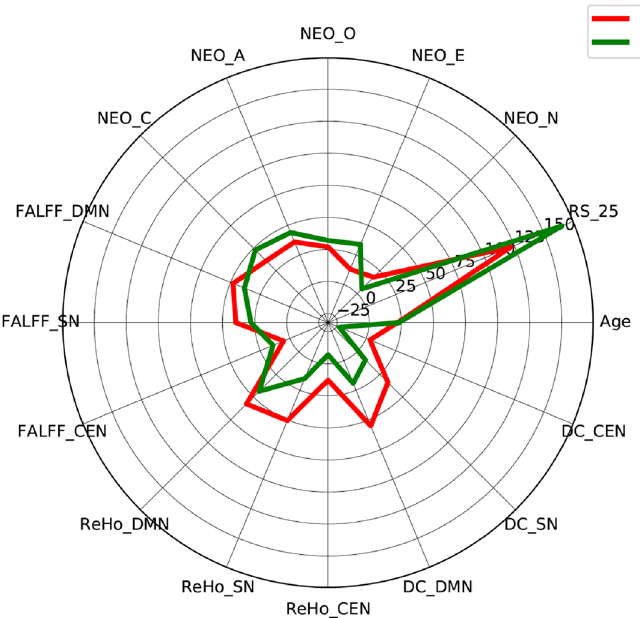
Figure 6. Individual depiction of the investigated behavioural (RS-25 and the 5 personality straits) and the fMRI metrics (ALFF, ReHo and DC) in the three core resting state networks for two age matched subjects: red line: male, intermediate resilience (RS = 122), 22 years and green line: male, high resilience (RS-25 = 165), 23 years. The figure was created using the Python (version 3.8.9) libraries numpy and matplotlib.